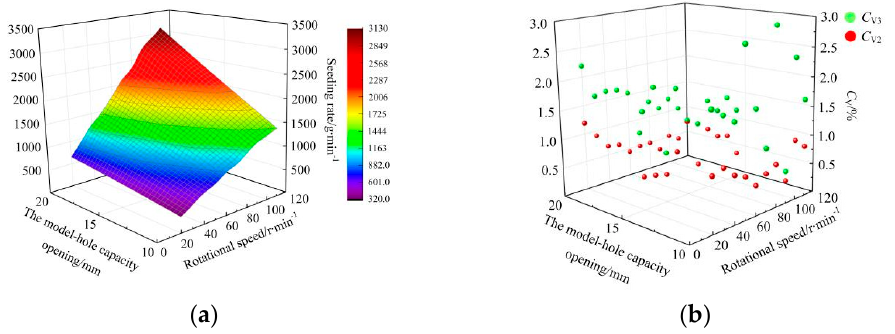
Figure 19. Effect of different rotational speed and model-hole volume opening on wheat seed metering performance. ( a ) Seeding rate under different operating speed and model-hole capacity opening; ( b ) Seeding performance under different operating speeds and model-hole capacity opening.